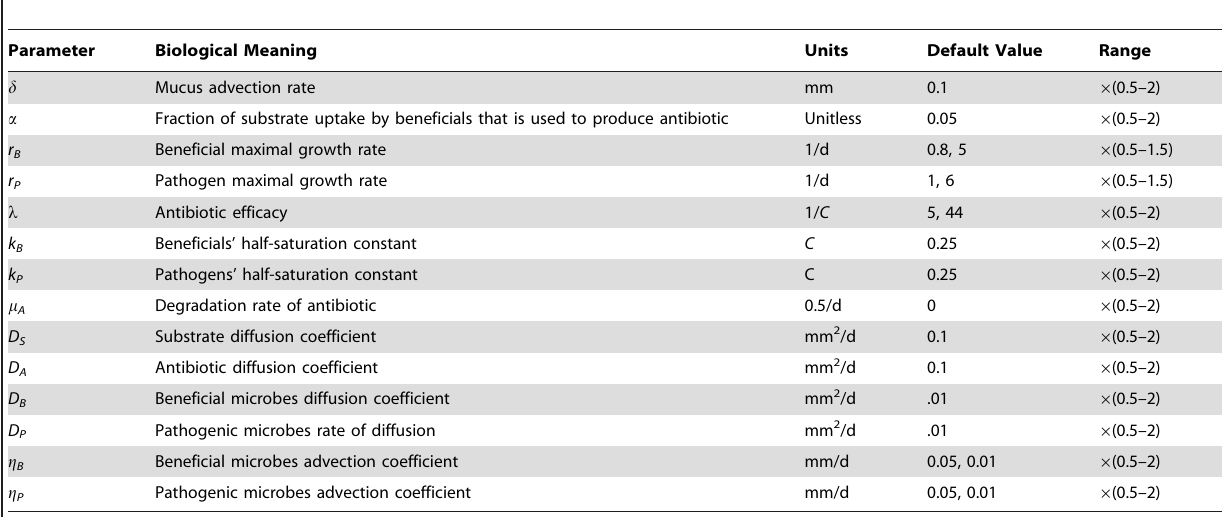
Table 1. Model parameters and their baseline values (see Text S4) for sensitivity analysis of the spatial model, after rescaling substrate concentration so that the concentration of substrate in fresh mucus supplied by the host is S 0 =1.